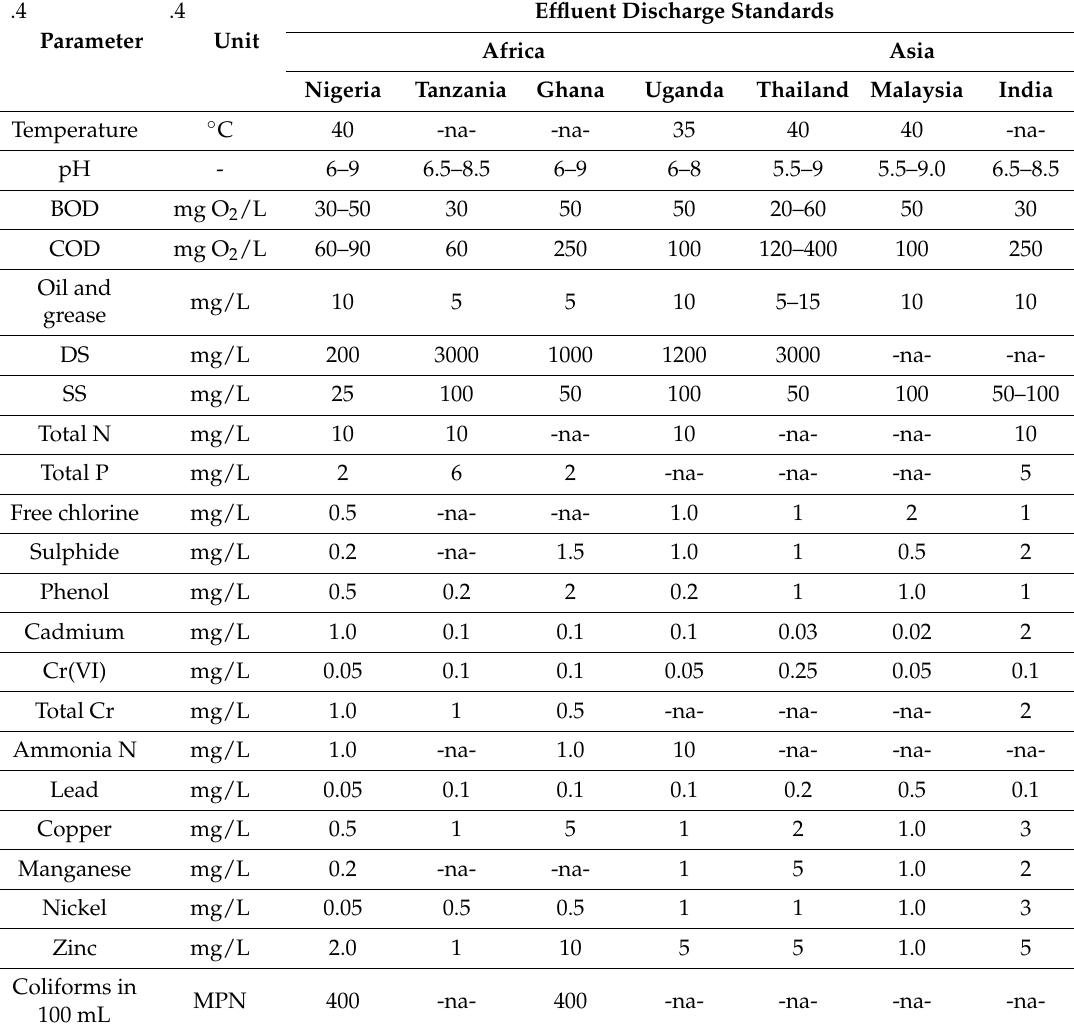
Table 1. Comparison of effluent discharge limits for various water quality parameters in Africa and